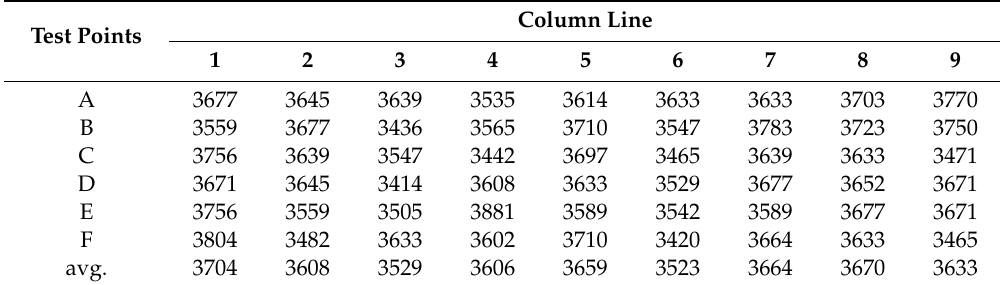
Table 3. P-wave velocities (m / s) at test grid points in S24D210 slab (unit: m / s).